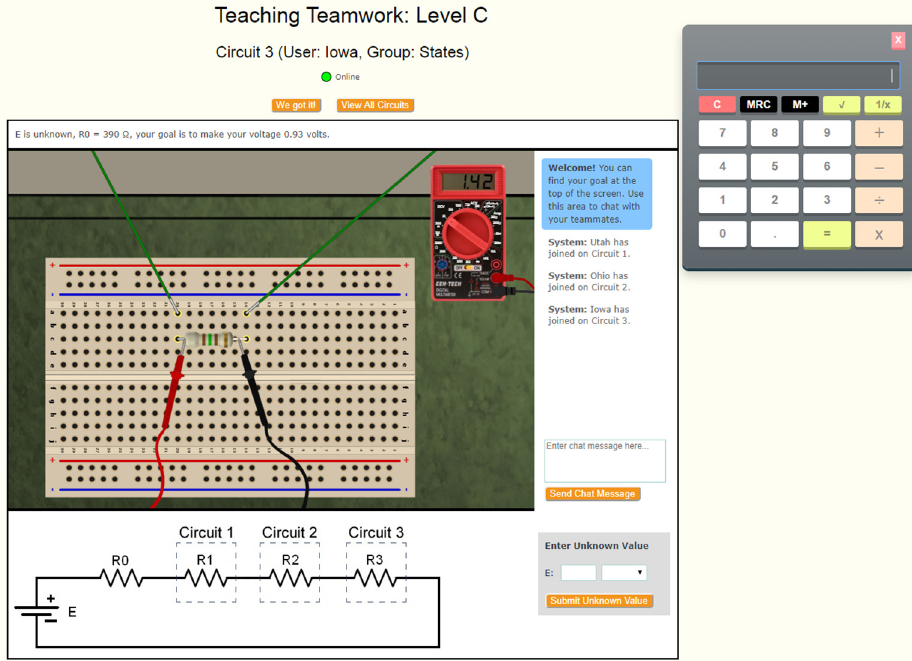
Figure 1. Screenshot of the Three-Resistor Activity interface. Table 1. Overview of Three-Resistor Activity